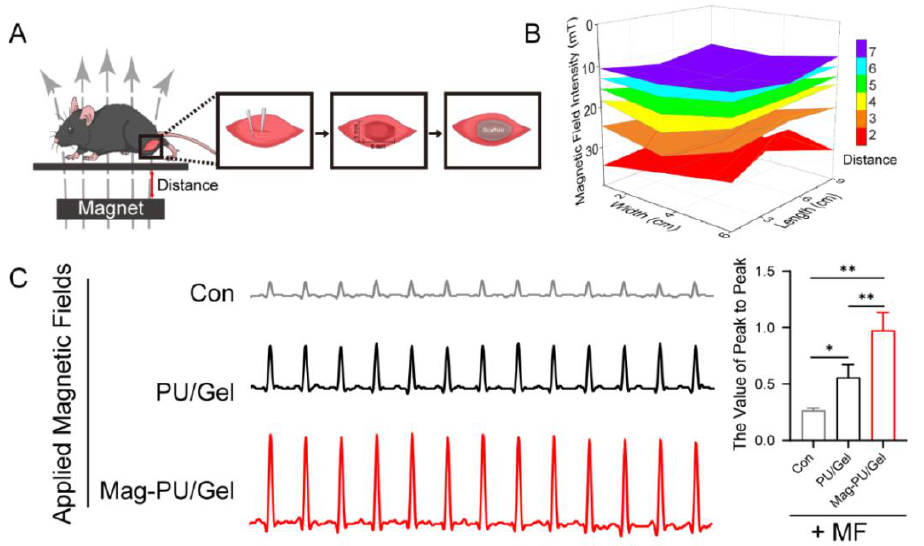
Figure 6. Effects of magnetic scaffolds combined with magnetic fields on the recovery of the elec- trophysiological function of the skeletal muscle. ( A ) Schematic diagram of animal experiments. ( B ) Strength distribution of magnetic fields in the cages for mice. ( C ) Muscle contraction tension curve of different groups in response to the electrical stimulation. These data were analyzed by one-way analysis of variance with Tukey’s post hoc test: * p < 0.05, ** p < 0.01. * indicated significant difference.